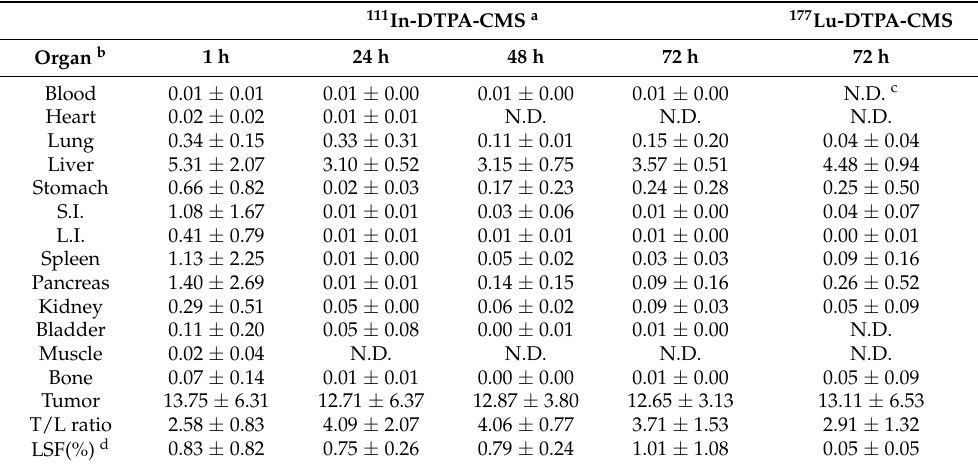
Table 1. Radioactivity distribution of 111 In- and 177 Lu-DTPA-CMS in rats with hepatoma N1-S1 after intraarterial injection.